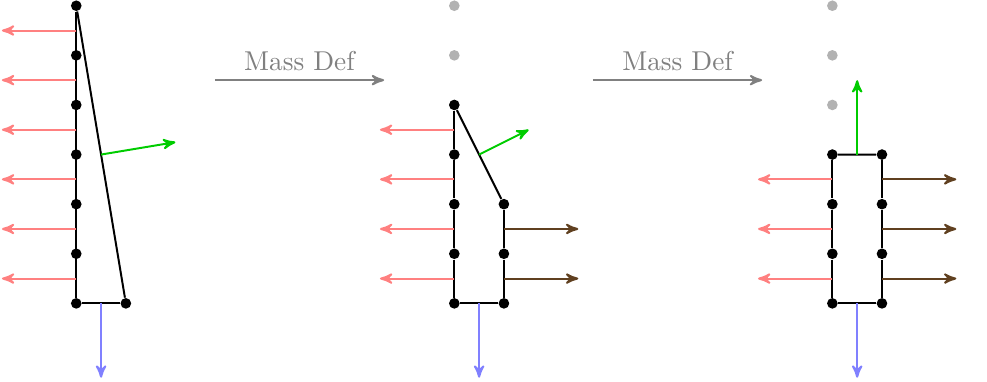
Figure 8. The chain of toric diagrams connected by mass deformation for n = 6 : C 2 / Z 6 × C → L 2 , 4 , 2 → L 3 , 3 , 3 , the number of points remains n + 2 = 8 all along. It holds also with the orientifold projection, mutatis